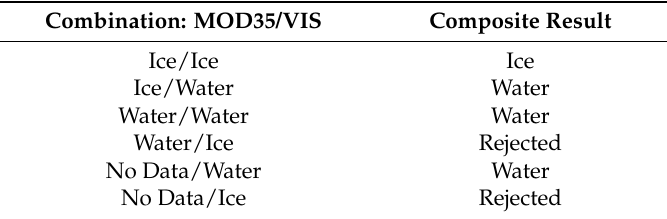
Table 2. Combination and outcomes of the composite